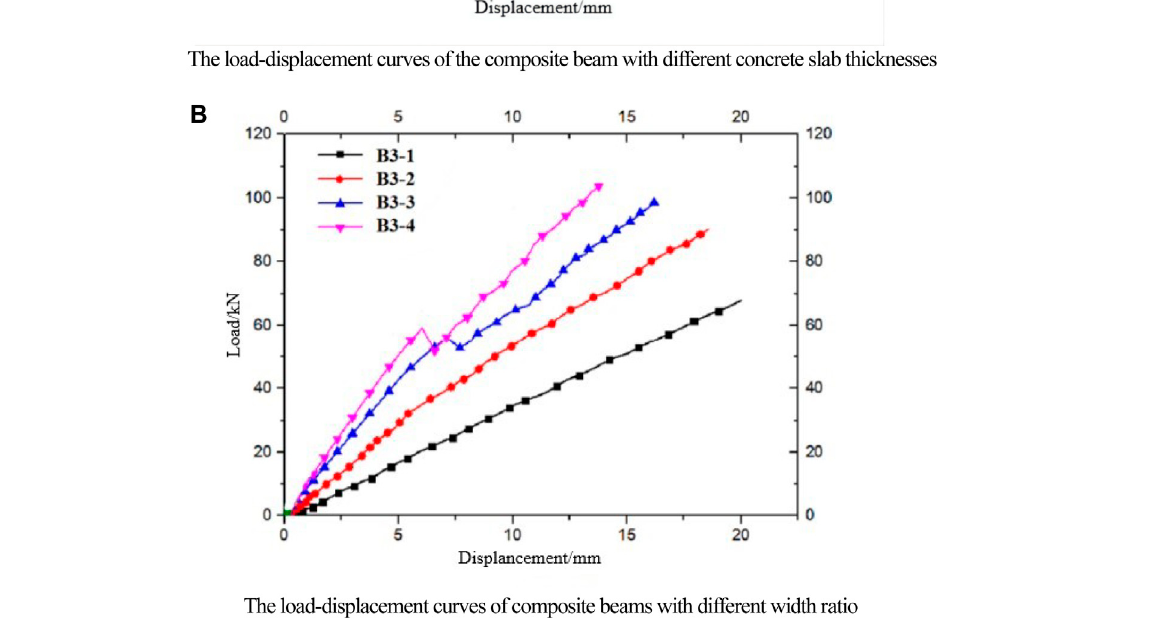
Frontiers in Materials |